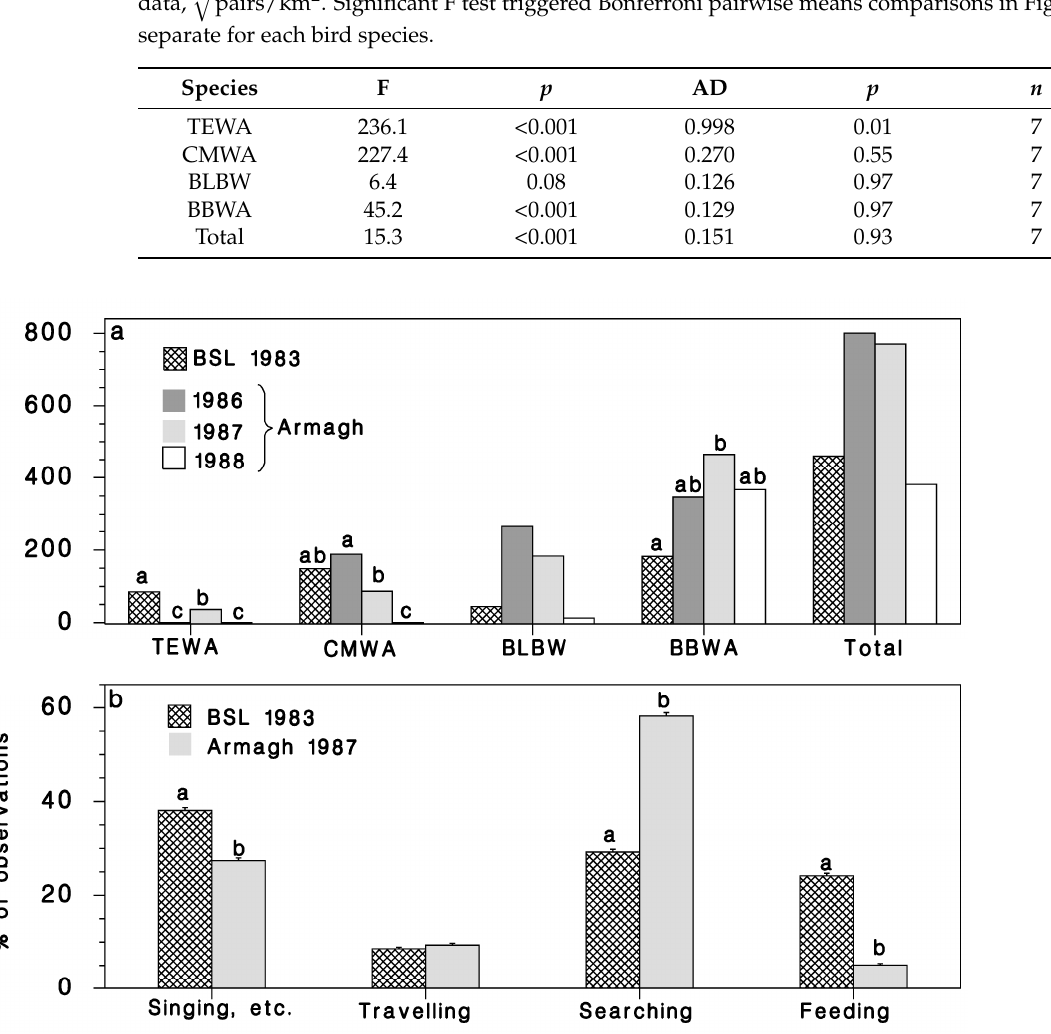
Figure 6. ( a ) Population density of four warbler species at Black Sturgeon Lake in 1983 (cross-hatched bars) and in Armagh in 1986, 1987, and 1988 (bars in decreasing shades of grey). Letters indicate Bonferroni mean-separation test results (within species). ( b ) Relative frequency of bird activity observations classified into four categories, at BSL in 1983 and Armagh in 1987. Letters indicate significant site differences ( χ 2 test of association) for each activity. Vertical lines: binomial standard p ( 1 − p ) / n error